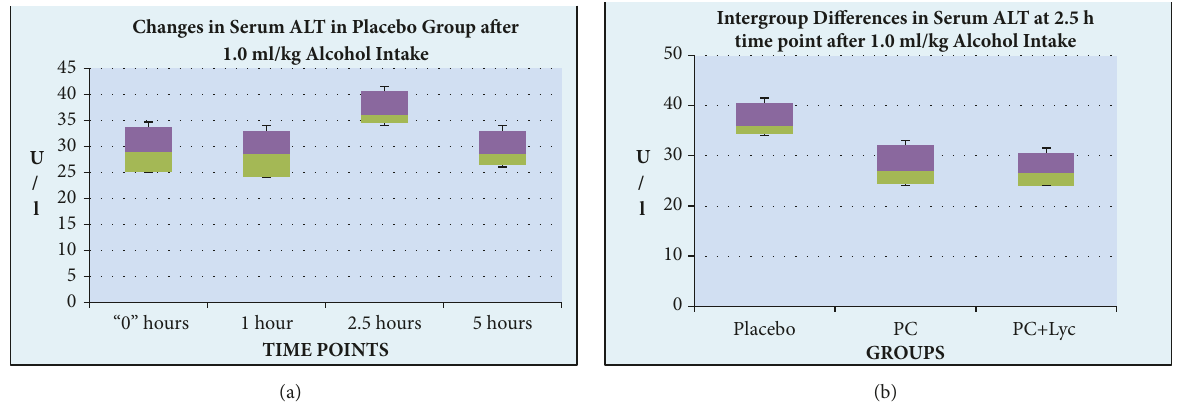
Figure 1: Time-course ALT changes (a) and intergroup ALT differences (b) after alcohol intake. Box-and-Whisker Analysis . The volunteers were enrolled, screened, and randomized as described in the Material and Methods and given study products as well as alcohol- containing beverages. The parameters were measured at “0” hours and after 1, 2.5, and 5 hours following the